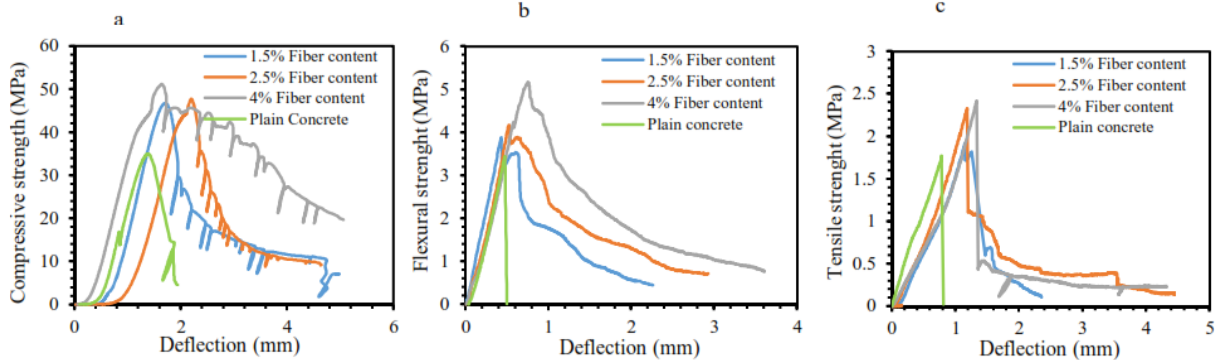
Figure 11: Results obtained from the tests at different proportions of steel fiber amount a. compressive test b. flexural test c. direct tensile test